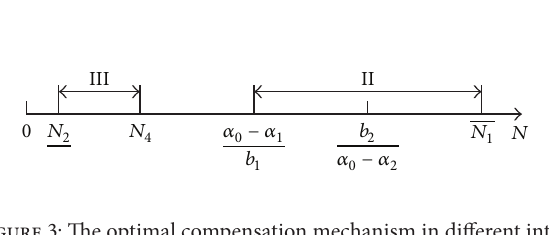
Figure 3: The optimal compensation mechanism in different